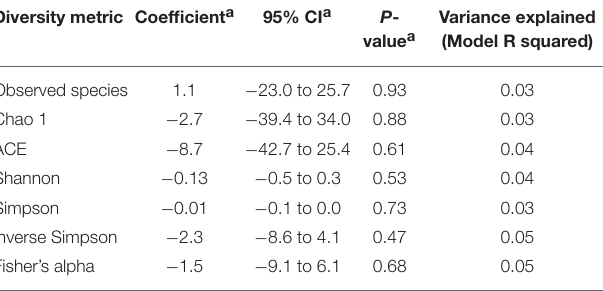
TABLE 2 | Adjusted linear regression coefficients for alpha diversity indices between P vs. H group. Diversity metric Coefficient a